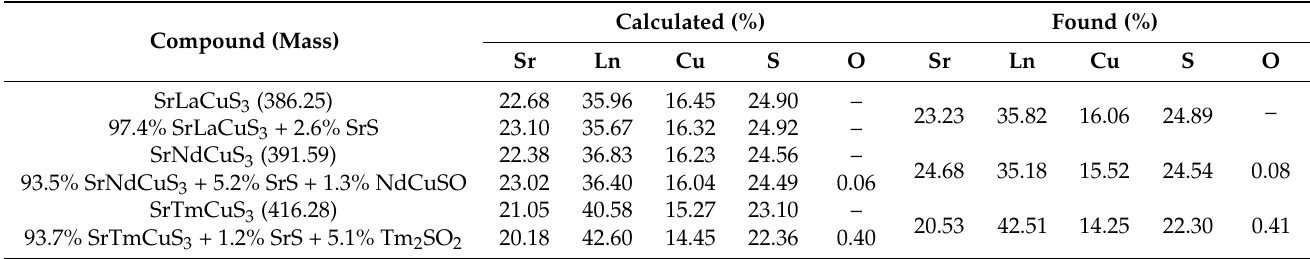
Table 6. The calculated and found elemental analysis data for SrLnCuS 3 (Ln = La, Nd, Tm) obtained using